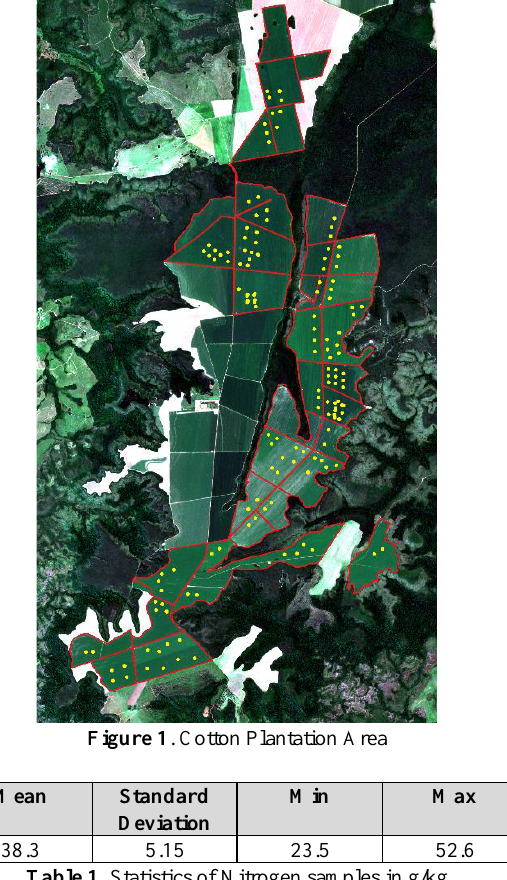
Table 1 . Statistics of Nitrogen samples in g/kg